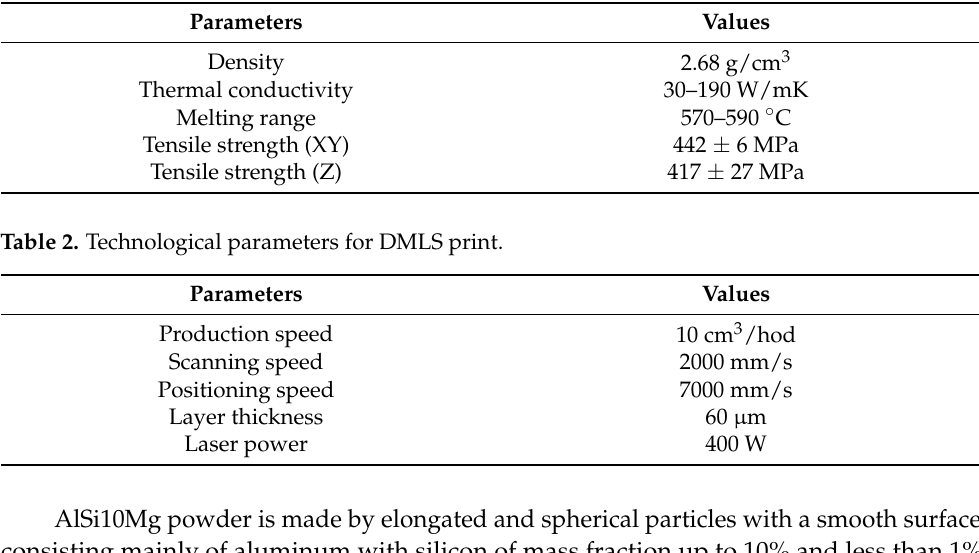
Table 1. Material characteristics [25].